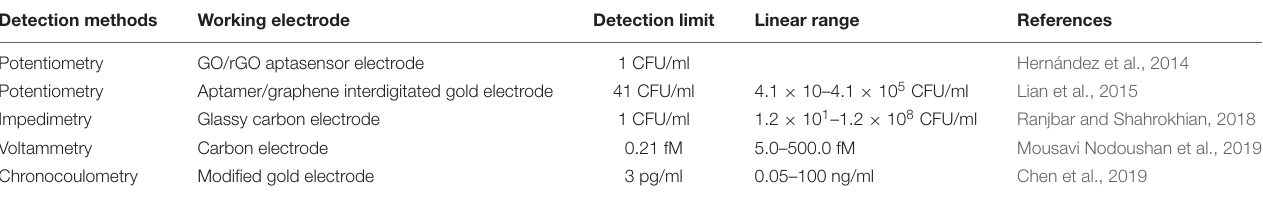
FIGURE 2 | Schematic illustration of detection principle of electrochemical aptasensors. TABLE 3 | Comparison of analytical features of electrochemically related aptasensors for S. aureus detection. Detection